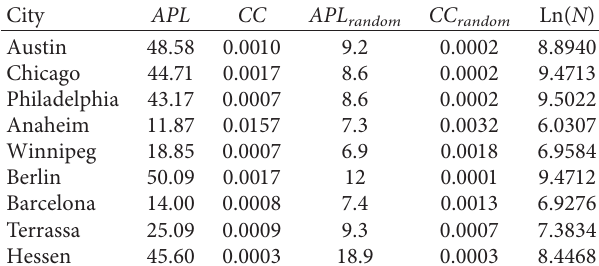
Figure 7: Comparisons between using Pajek and other approximation formulas. Table 6: APL and CC comparisons between nine URNs and the corresponding random networks of the same